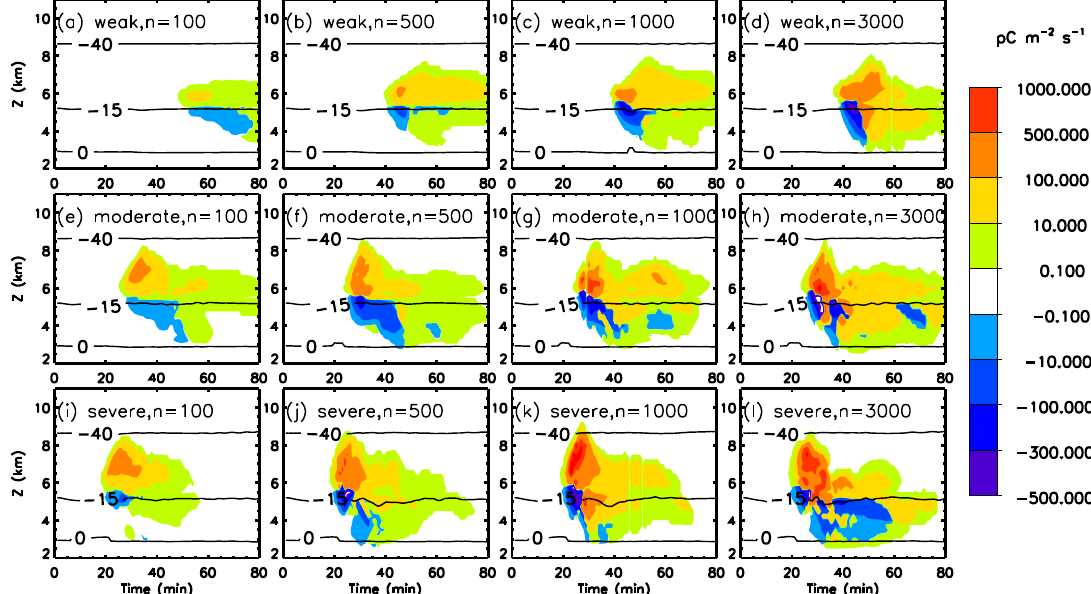
14 of 21 Figure 10. Vertical profiles of the maximum mixing ratio and the maximum number concentration of graupel in ( a ) weak thundercloud, ( b ) moderate thundercloud, ( c ) severe thundercloud; the maximum number concentration of ice crystals in ( d ) weak thundercloud, ( e ) moderate thundercloud, ( f ) severe thundercloud. 3.2. Charging Rate The electrification process of the thundercloud is based on the non-inductive electrification mechanism of ice crystals and graupel particles and the inductive charging between graupel and cloud droplets [42]. Therefore, the concentration of graupel is one of the key factors affecting the electrification process [55]. From the analysis in the previous section, we know that the cloud droplets, ice crystals, and graupel are sensitive to CCN concentration, so the change of those hydrometer particles should lead to a different electrification process with different CCN concentrations. The time evolution of the non-inductive charging rate is given in Figure 11. The negative non-inductive charging rate of all cases roughly resides between 3 and 5 km (0 to − 15 °C), while the stronger production of ice particles makes a greater contribution to actively positive non-